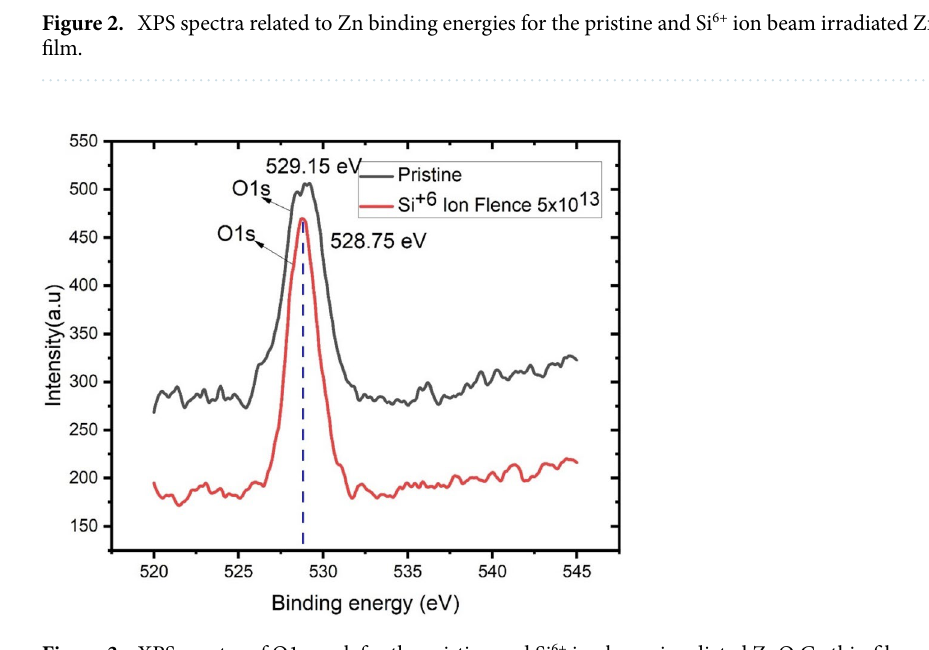
Figure 3. XPS spectra of O1s peak for the pristine and Si 6+ ion beam irradiated ZnO:Ga thin